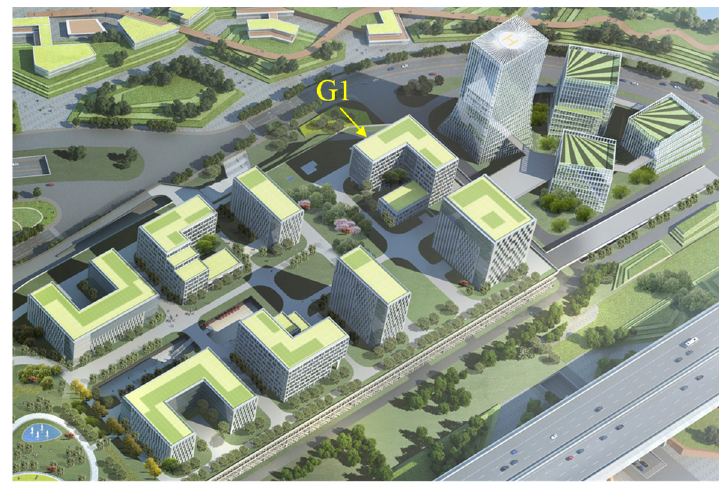
Figure 1. Bird’s eye view of the indicated thirteen high-rise buildings.